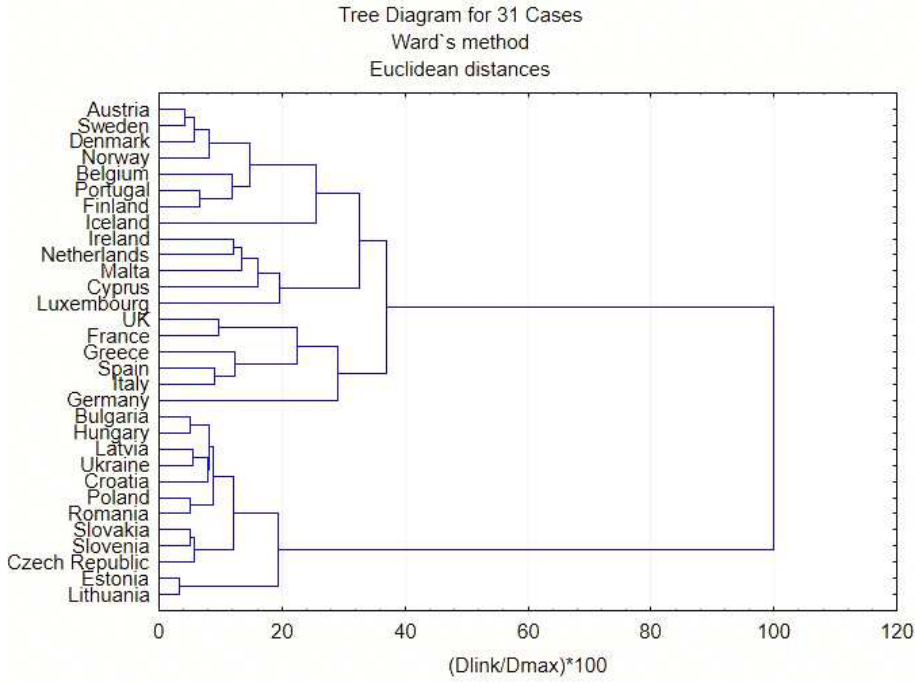
Figure 1. Dendrogram for 31 countries (Ward’s